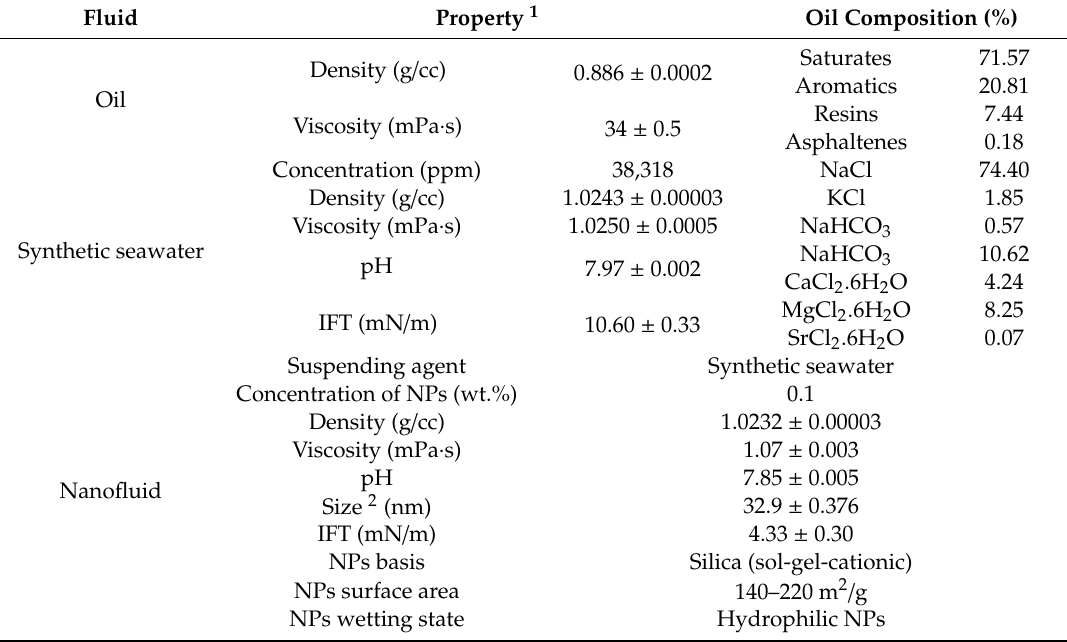
Table 2. Properties and composition of the oil, synthetic seawater, and nanofluid in this study.